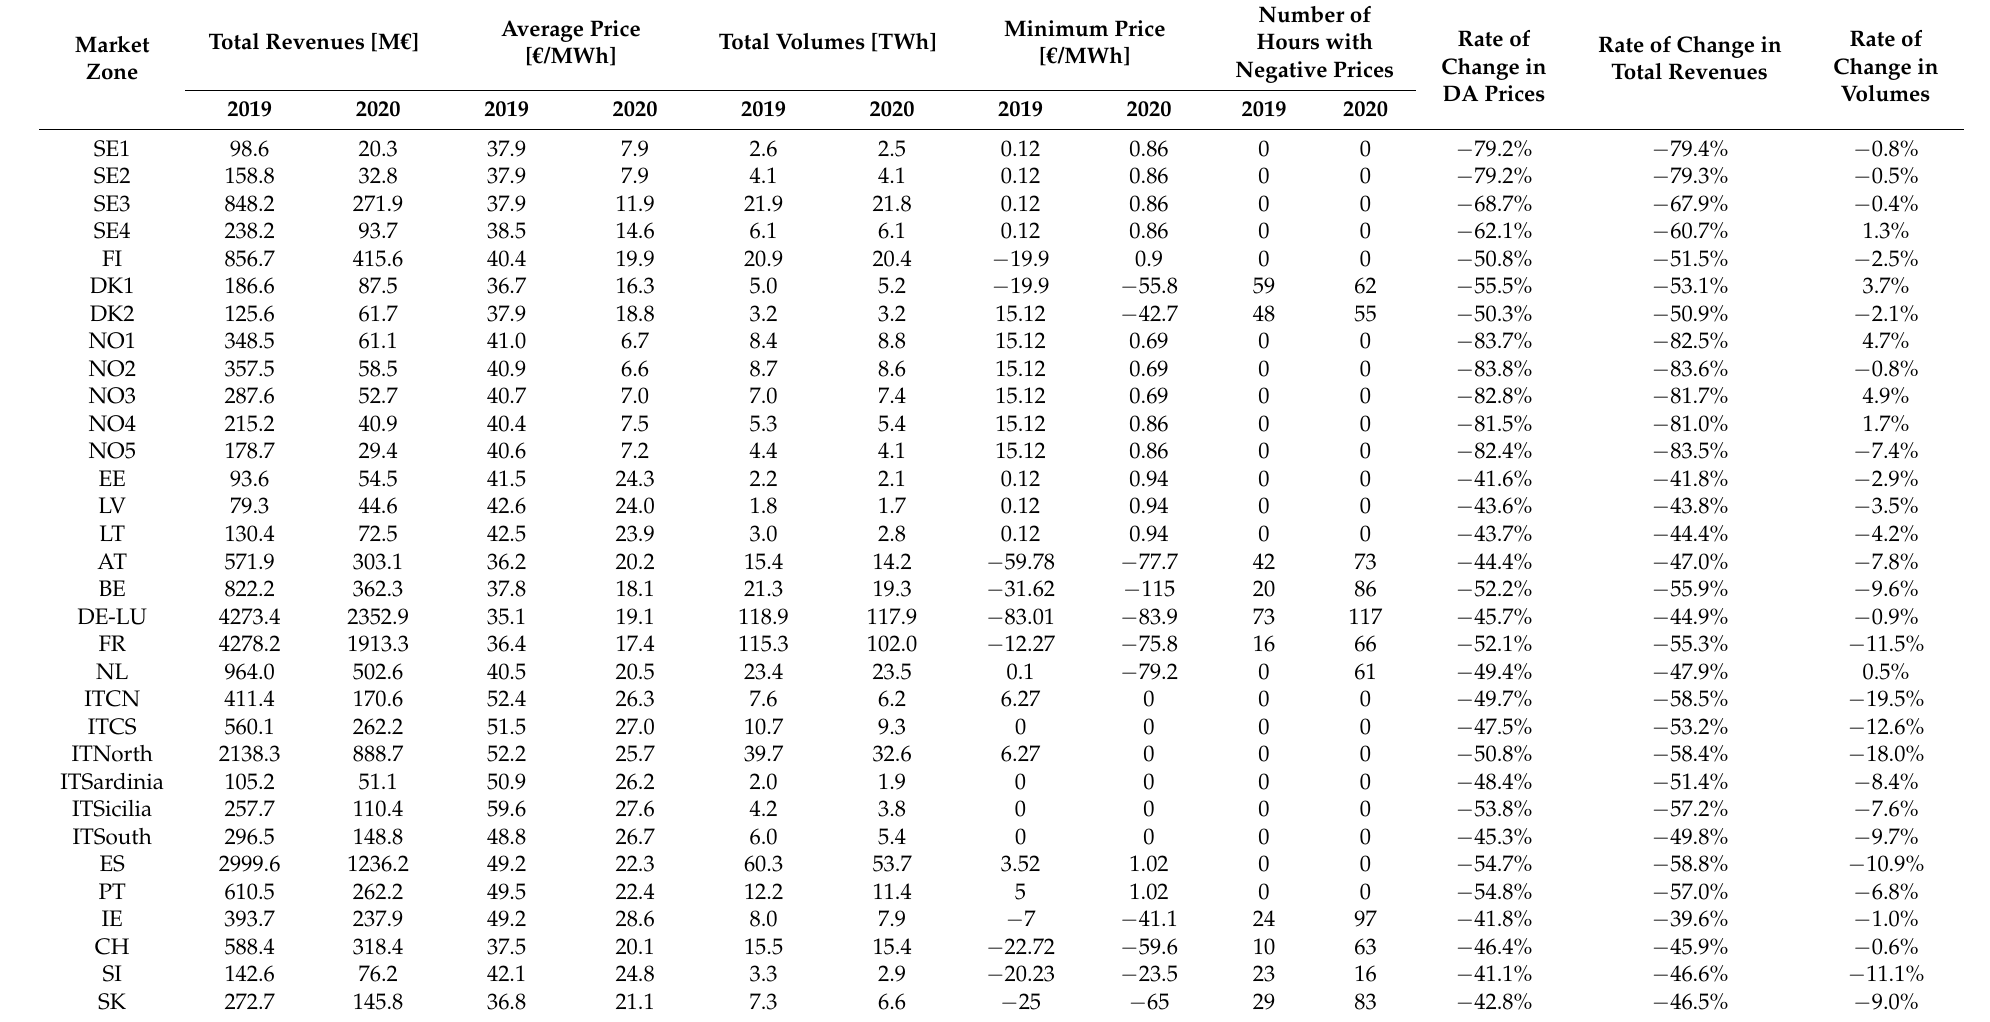
Table A4. Total revenues, average and minimum prices, volumes, number of hours with negative prices and variations in the day-ahead market. Data corresponding to Sweden, Norway, Denmark, and Italy are presented disaggregated in their bidding zones. For the current EU Bidding Zone configuration, please refer to